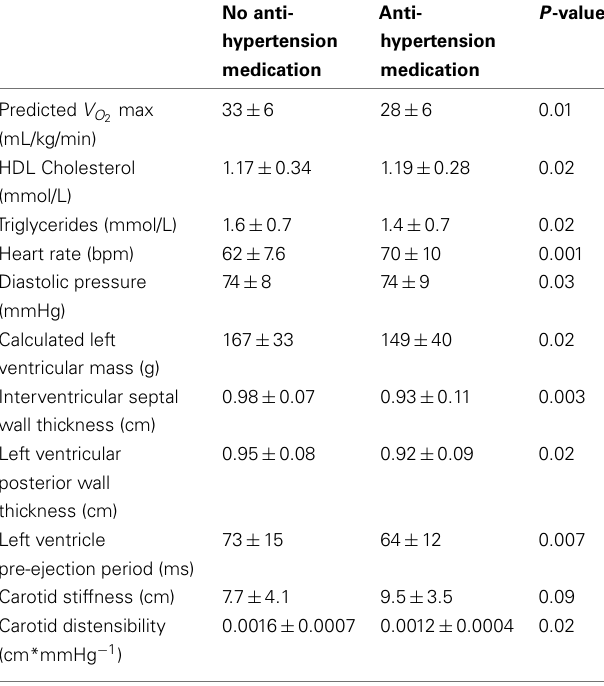
Table 4 | Effects of anti-hypertension medication.